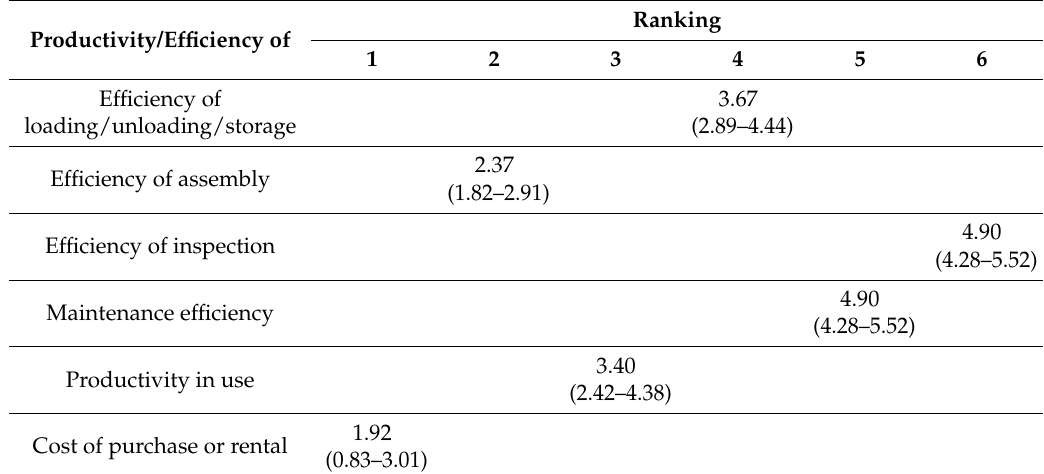
Table 7. Ranking of factors influencing the choice of scaffolding